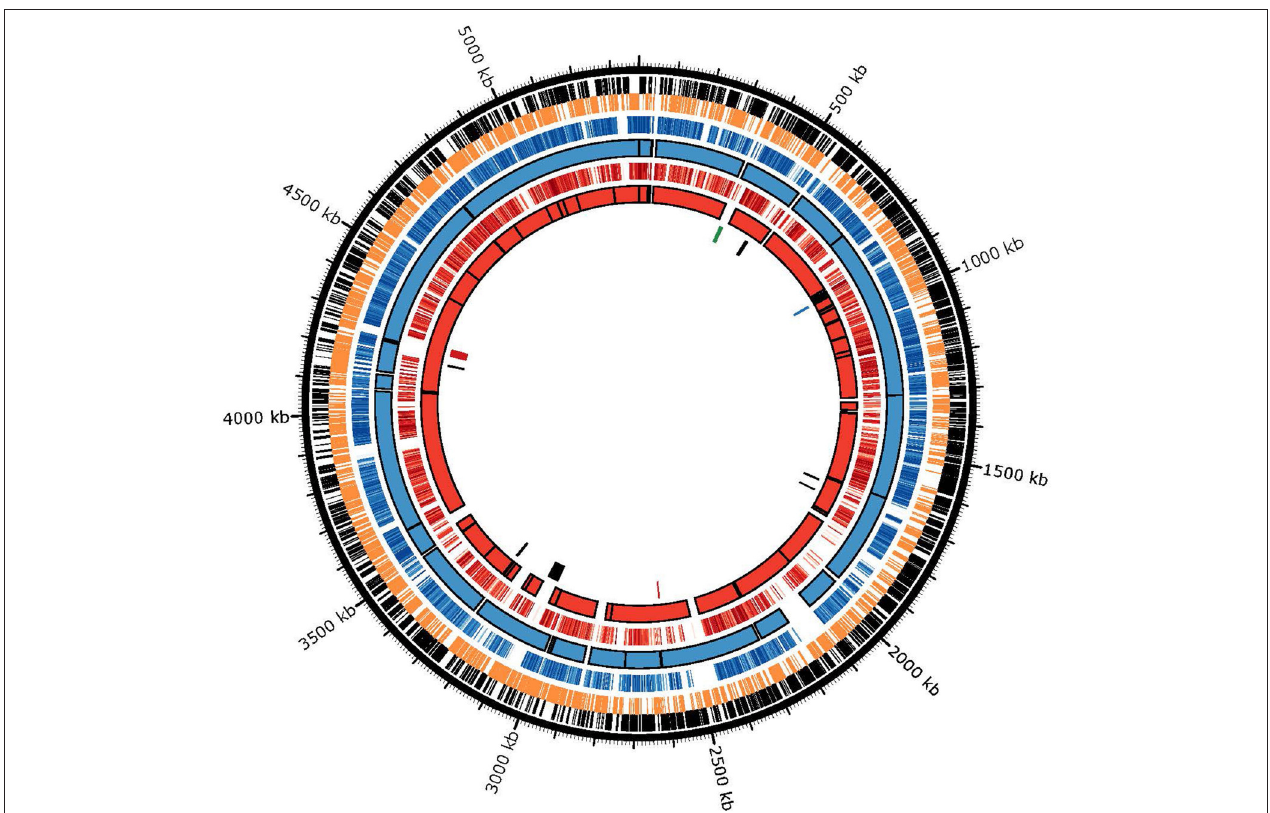
FIGURE 5 | BLAST atlas comparing homologous genes. (Outer ring) 34H positive strand genes are shown in black. (Second ring) 34H negative strand genes are shown in orange (Third ring) Genes in ND2E with greater than 50% nucleotide identity to a gene in 34H are shown as blue lines. Darker blue lines are genes with higher identity to the gene in 34H and lighter blue lines have are less identical to the gene in 34H. (Fourth ring) ND2E Contigs are depicted as blue blocks. (Fifth ring) Genes in GAB14E with greater than 50% nucleotide identity to a gene in 34H are shown as red lines. Darker red lines are genes with higher identity to the gene in 34H and lighter red lines have are less identical to the gene in 34H. (Sixth ring) GAB14E Contigs are depicted as blue blocks. (Seventh ring) Putative genomic islands as predicted by island viewer. Genomic islands shown in red have been previously described ( Collins and Deming, 2013). The genomic islands shown in blue corresponds to one of the two previously described filamentous phage (Methé et al., 2005). One of the previously described filamentous phage that was not predicted to be a genomic island is shown in